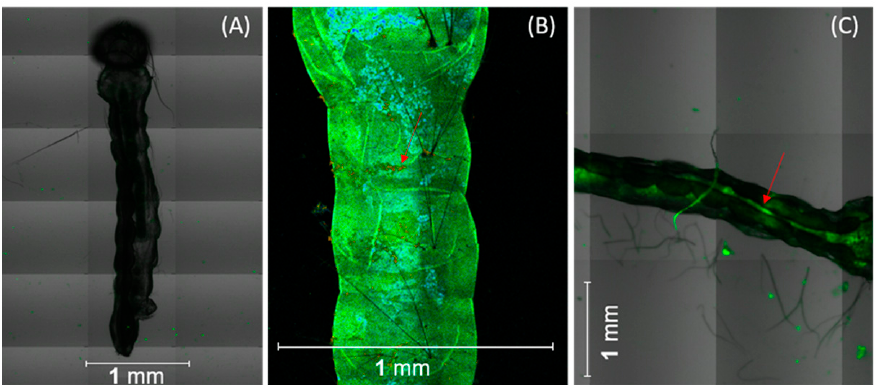
Figure 1. Representative confocal microscopy images of Ae. aegypti larvae: ( A ) non-subjected to synthetic curcumin with sucrose SCS (control) and exposed to SCS with curcumin, ( B ) attached to the larval body surface (arrow), and ( C ) located in the midgut. Scale bars represent 1 mm. The pupal formation and mortality rate of the larvae added to the sucrose (control group) and SCS formulation (experimental group) as a function of the time are shown in Figure 2.